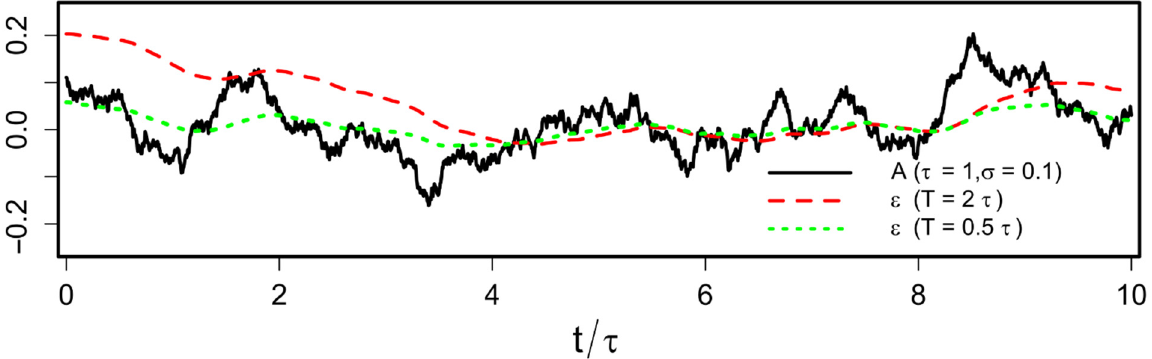
Figure 1. Evolution for the environmental fluctuations A (solid black line); and the population fluc- tuations for 𝑇 = 2 𝜏 ( ⇒ 𝛾 = 0.5/𝜏 ) (red dashed line), and 𝑇 = 0.5 𝜏 ( ⇒ 𝛾 = 2/𝜏 ) (green pointed line) for 𝜎 = 0.1 , 𝜆 = 1 and 𝜏 = 1 . Population fluctuations peak a short time after environmental fluctuations peak, indicating a delayed correlation between environmental and population fluctua- tions. Table 1. Variables used with its description and units.